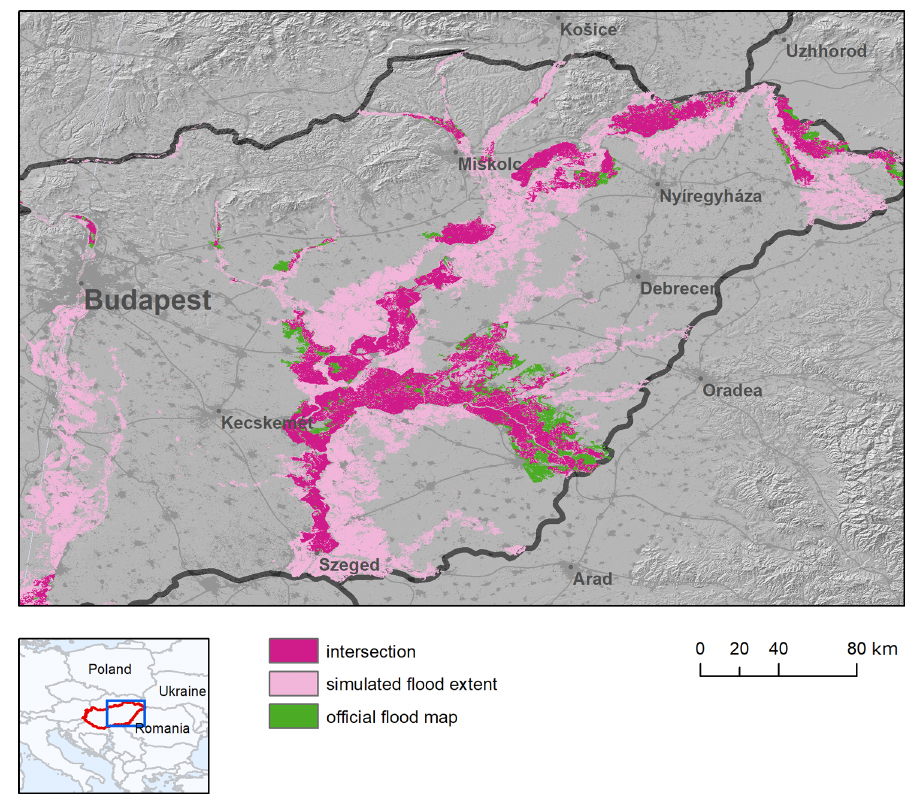
Figure 5. Comparison of modelled (blue) and reference (green) flood hazard maps (1-in-100-year flood hazard) over the Danube (left) and Tisza (right) rivers in Hungary. Purple areas denote the intersection between the modelled and reference set of